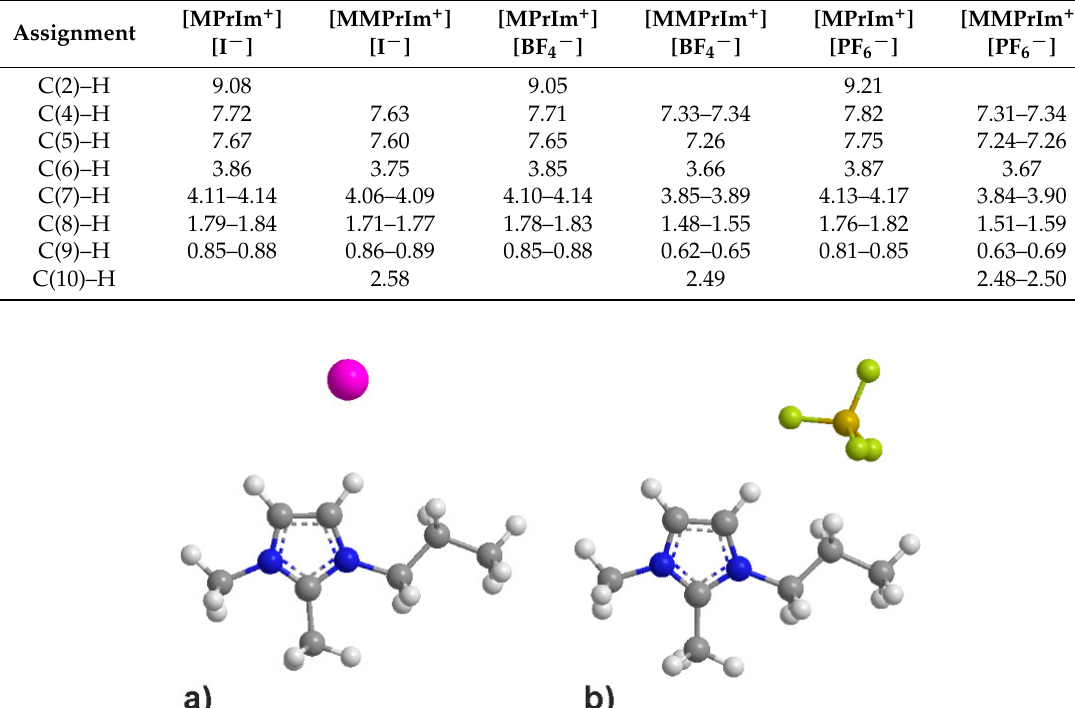
Figure 5. Schematic interaction geometries of ( a ) [MMPrIm + ][I − ] and ( b ) [MMPrIm + ][BF 4 − ]. The geometries were energetically optimized using the MM2 function of ChemDraw, but they may not accurately represent the true configuration due to the simplistic underlying model. They are meant to serve as a general illustration of the interaction.